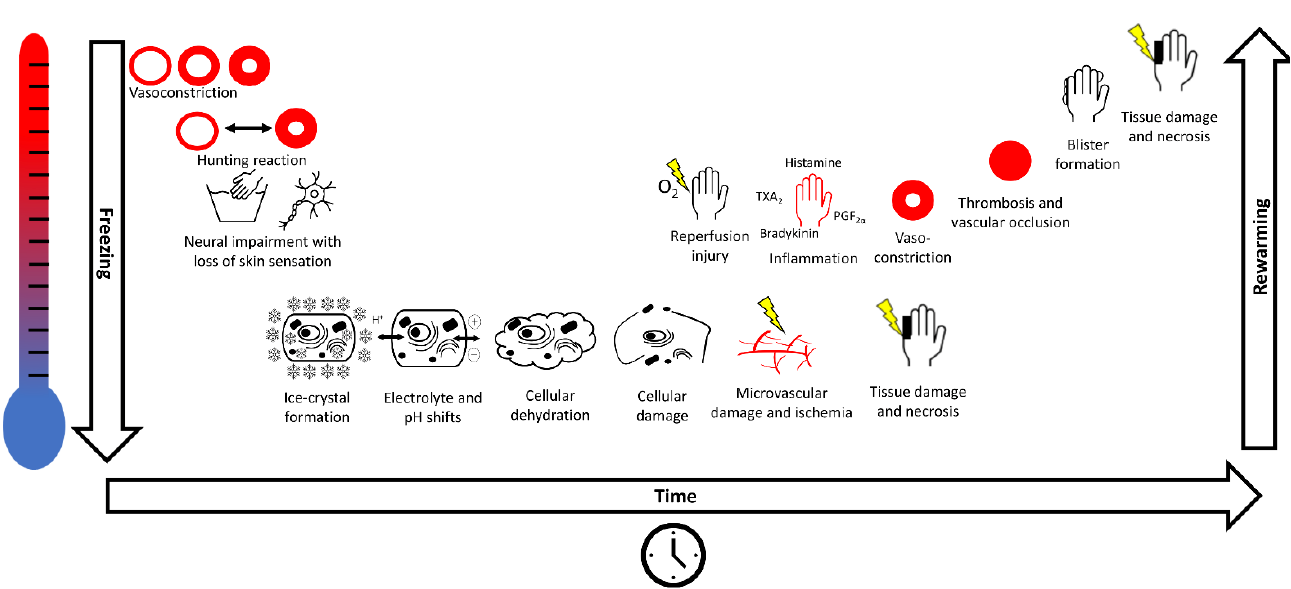
Figure 1. Pathophysiological cascade of frostbite. Cooling of the skin leads to vasoconstriction and to cycles of intermittent vasodilation and vasoconstriction, known as the “Hunting reaction”. Eventually neuronal impairment occurs with loss of sensation. Skin freezes with formation of extracellular ice-crystals that leads to electrolyte and pH shifts, cellular dehydration, and cell damage. Damage to the microvasculature results in ischaemia, tissue damage and necrosis, worsening over time. When skin is rewarmed, injury leads to inflammation, vasoconstriction, thrombosis, vascular occlusion, blister formation and eventually to tissue damage and necrosis.